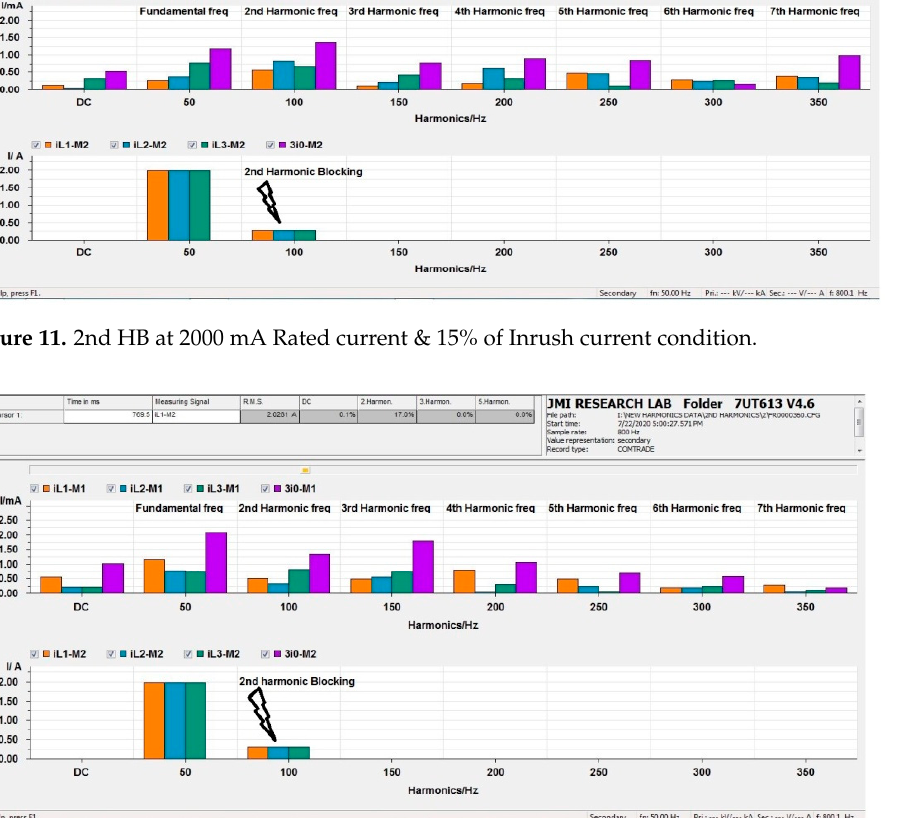
14 of 26 Figure 9. 2nd HB at 1000 mA Rated current & 18% of Inrush current condition.